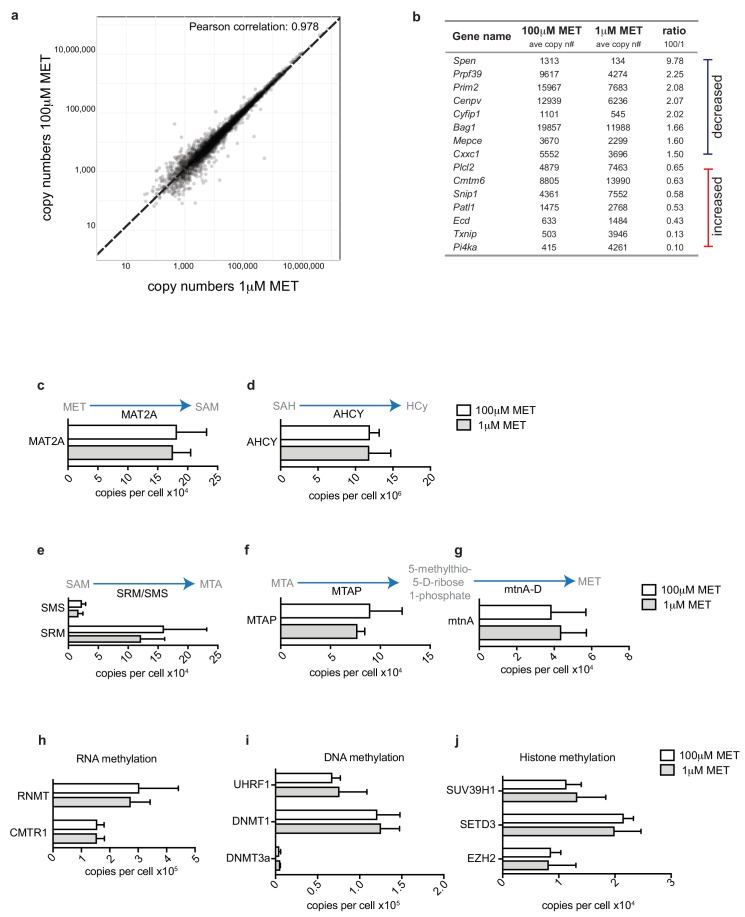
Acute methionine restriction on methionine cycle proteome Quantitative ‘single-shot’ proteomics was performed on in vitro generated IL2 maintained Th1 cells cultured for 5 hr in 100 μM or 1 μM methionine.(a) The graph shows the protein copy numbers in Th1 cultured with 1 μM methionine plotted against those in 100 μM methionine. Pearson correlation is indicated. (b) Proteins that were significantly differentially expressed (P = <0.05, with a 1.5 fold cut-off) are listed by gene name. They are ranked as most decreased by acute methionine deprivation to those that are increased. (c-g) The graphs show mean copy numbers (estimated using the proteomic ruler protocol) of (c) MAT2A, (d) AHCY, (e) SMS/SRM, (f) MTAP and (g) mtnA. (h-j) The graphs show mean copy numbers of (h) RNA cap methyltransferases RNMT and CMTR1; (i) DNA methyltransferase complex components UHRF1, DNMT1 and DNMt3a and (j) histone methyltransferases SUV39H1, SETD3 and EZH2. (Error bars are mean ± s.d. Data are from three biological replicates.).